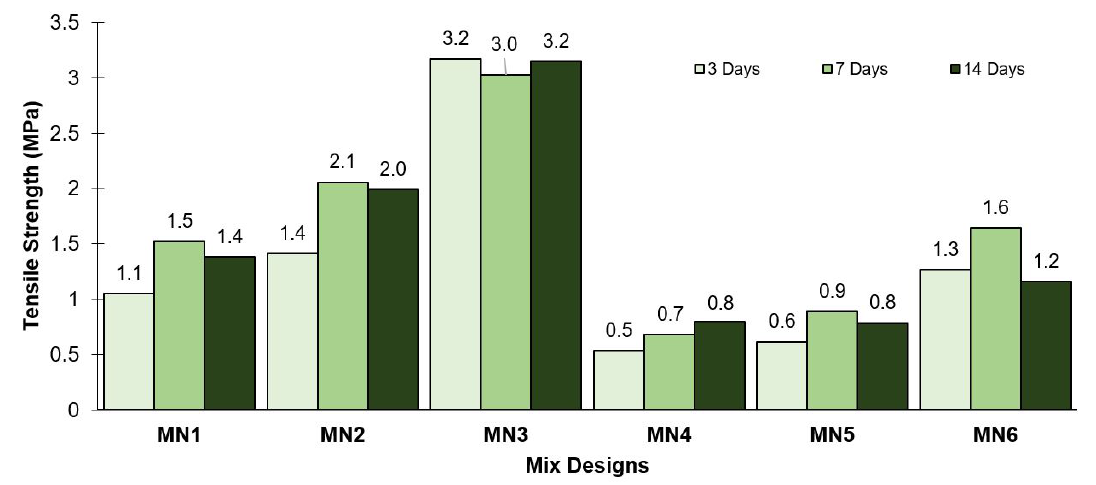
Figure 7: Splitting tensile strength for mixes containing 50% and 100% of coarse aggregate replacement by PL at 3, 7, and 14 days of